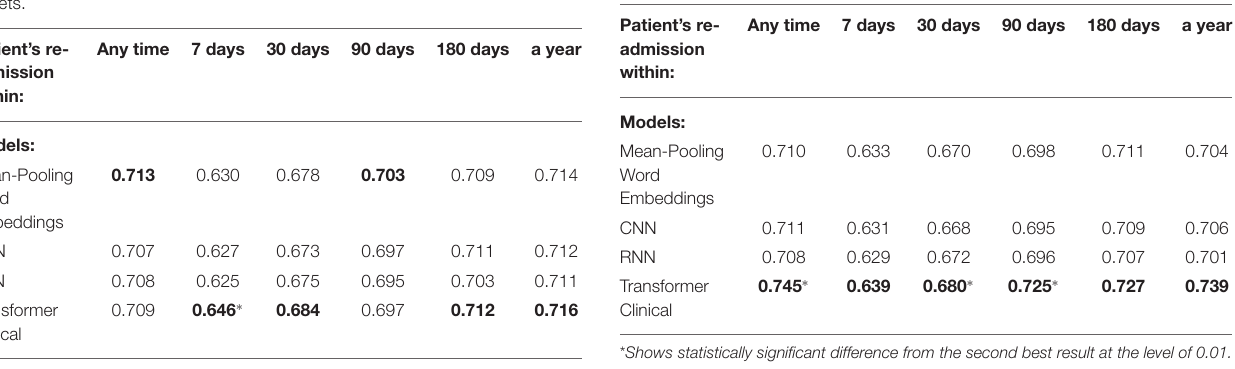
TABLE 8 | Comparison of the deep neural models on the tail portions (last 512 tokens) of discharge summaries for the re-admission prediction targets.